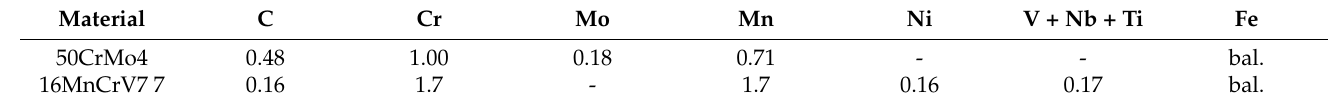
Table 1. Chemical composition of the two steels A and B used in this study (in wt%).